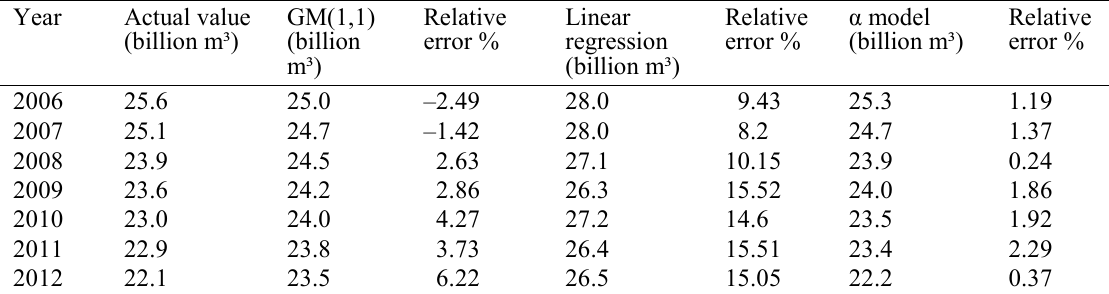
Table 4 The comparison of actual values and the predicted